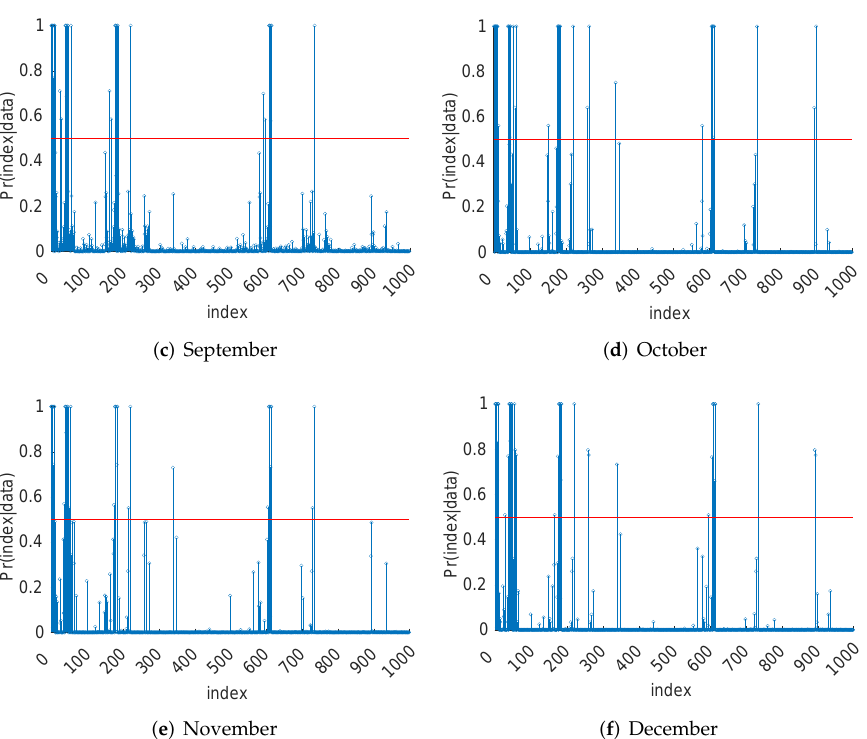
Figure 2. Plots of significant posterior marginal inclusion probabilities: July–December.